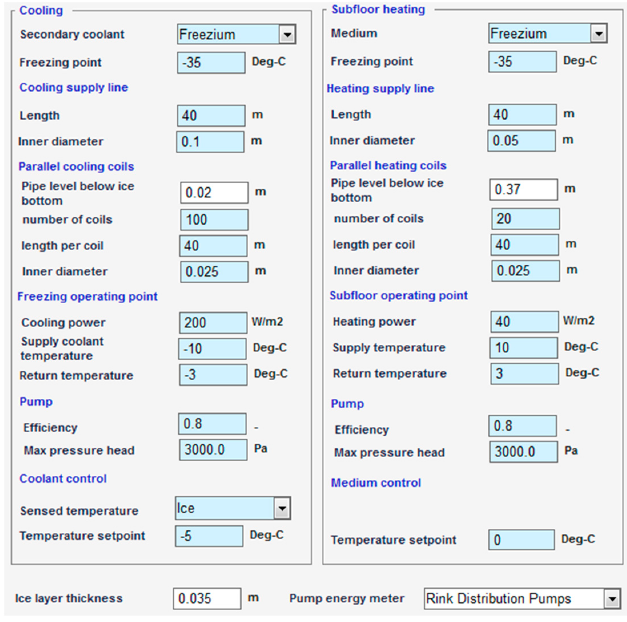
Figure 8. Refrigeration plant and the ice pad set points.